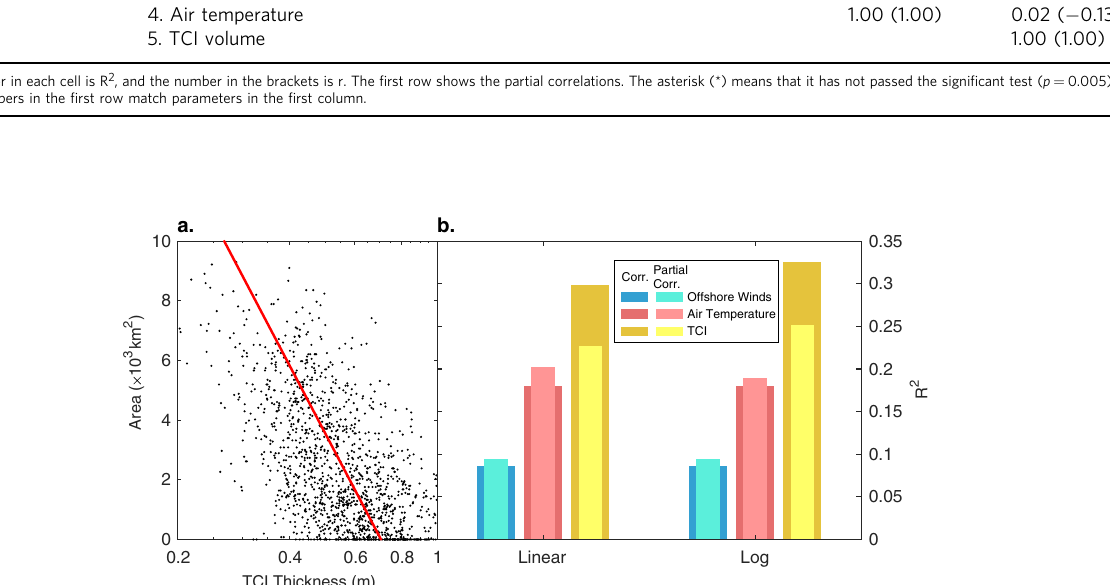
Fig. 6 The scatter between the TNBP area and the TCI thickness, and the correlation between the factors and the area. a Scatter and trend line (red) of negative exponent. b Offshore wind speed, air temperature, and TCI thickness. The left bars represent the results from the raw ice thickness and the right bars represent the results that the ice thickness is taken the logarithm. The outside bars show the correlation coef fi cient and the inside bars show the partial correlation coef fi